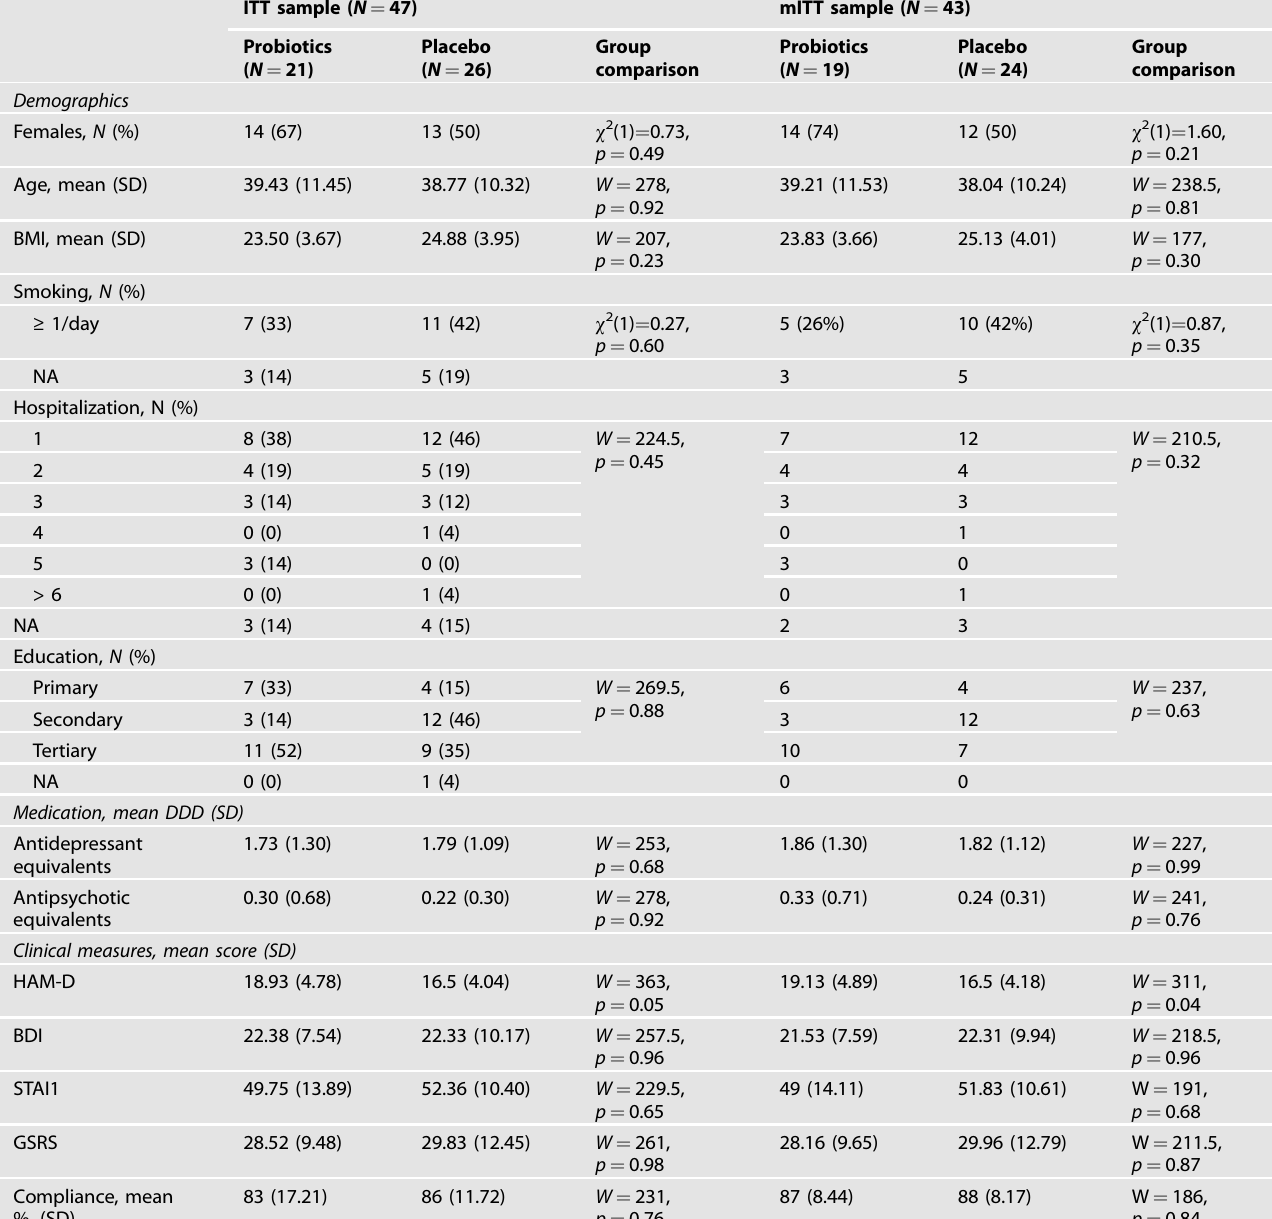
Table 1. Demographics and clinical measures of both study groups at